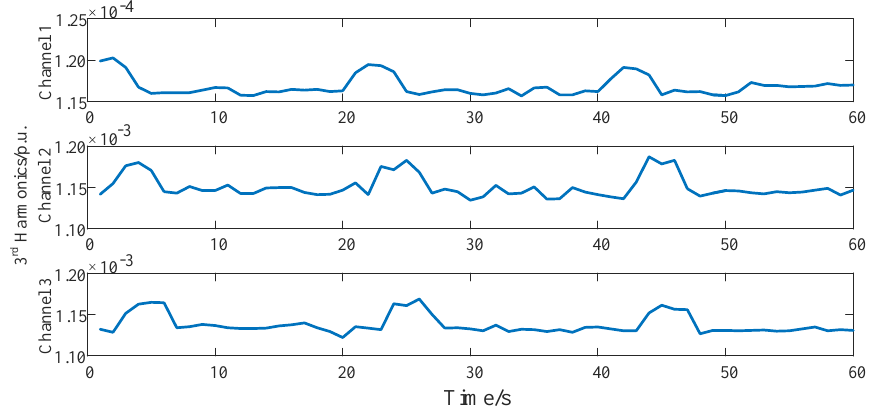
Figure 9. Third current harmonics of 3 typical channels at the same point of common coupling (PCC). The harmonics are independent and non-stationary in all 3 channels.